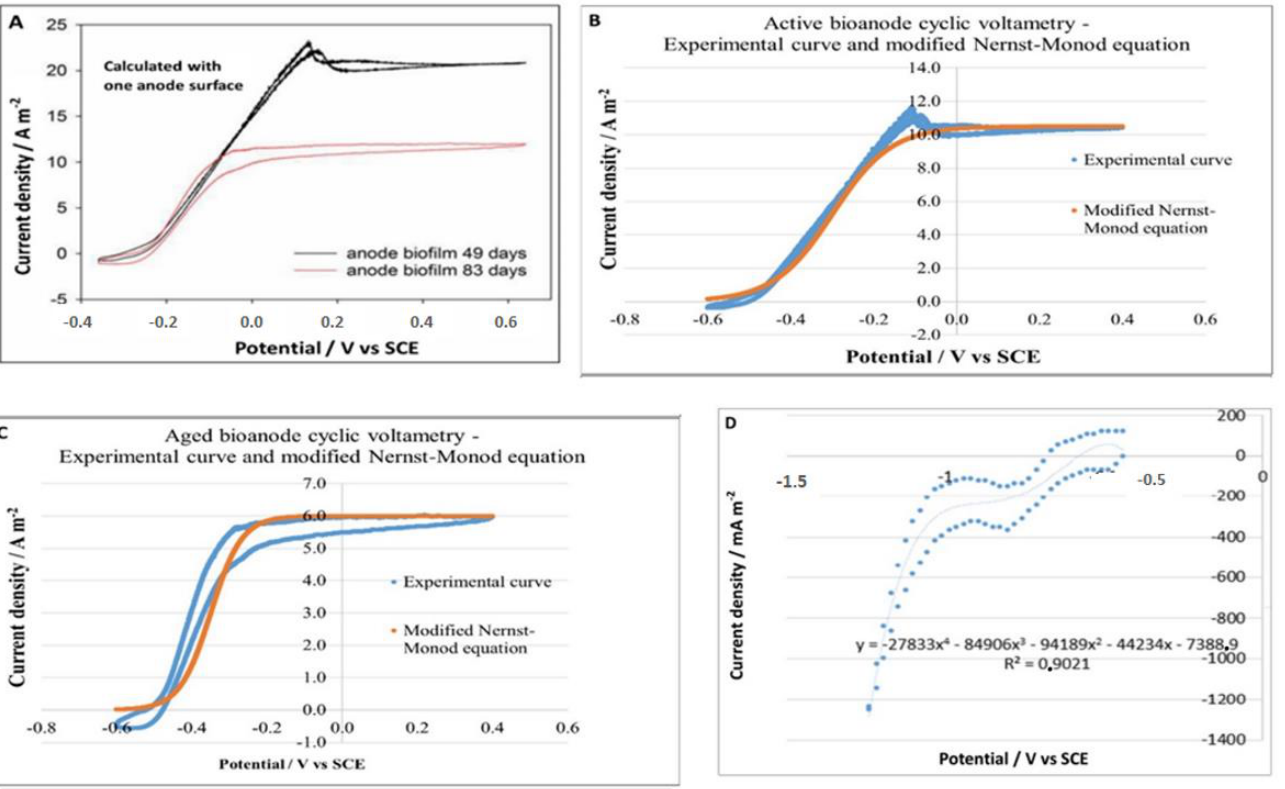
Figure 6. ( A ) Cyclic voltammetry of a fully matured and active bioanode (black curve) and an “aged” bioanode (red curve). The dates on the figure are not related to this work but indicate the occurrence time of the “aging” effect. ( B ) Modification of the Nernst-Monod equation for active bioanode kinetics. ( C ) Adaptation of the Nerst-Monod equation for the kinetics of “aged” bioanodes ( D ) adaptation of a polynomial equation for the kinetics of the granular carbon